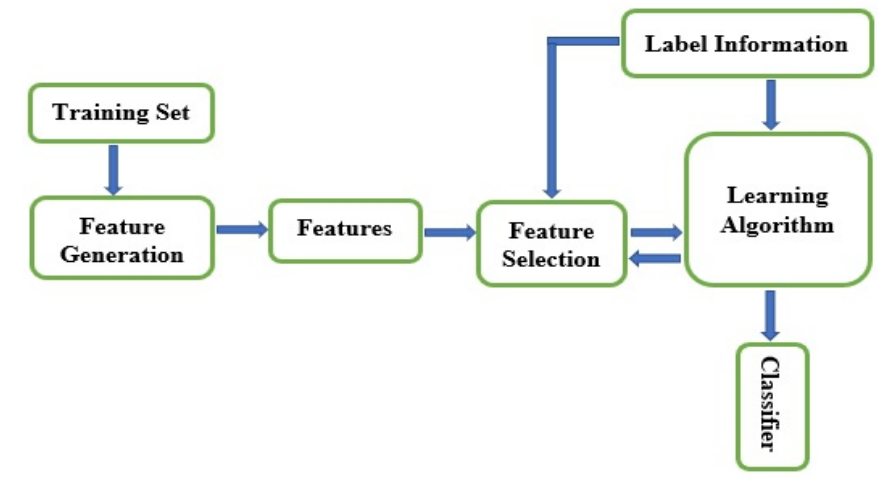
Figure 3. Framework of feature selection.